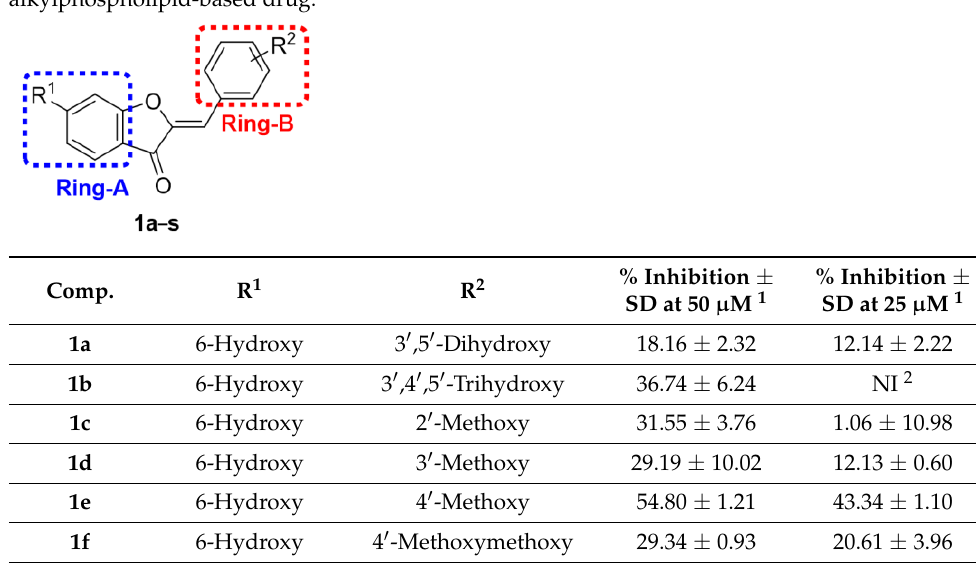
Table 2. Antileishmanial activities of sulfuretin analogs ( 1a − s ), sulfuretin and a standard alkylphospholipid-based drug.